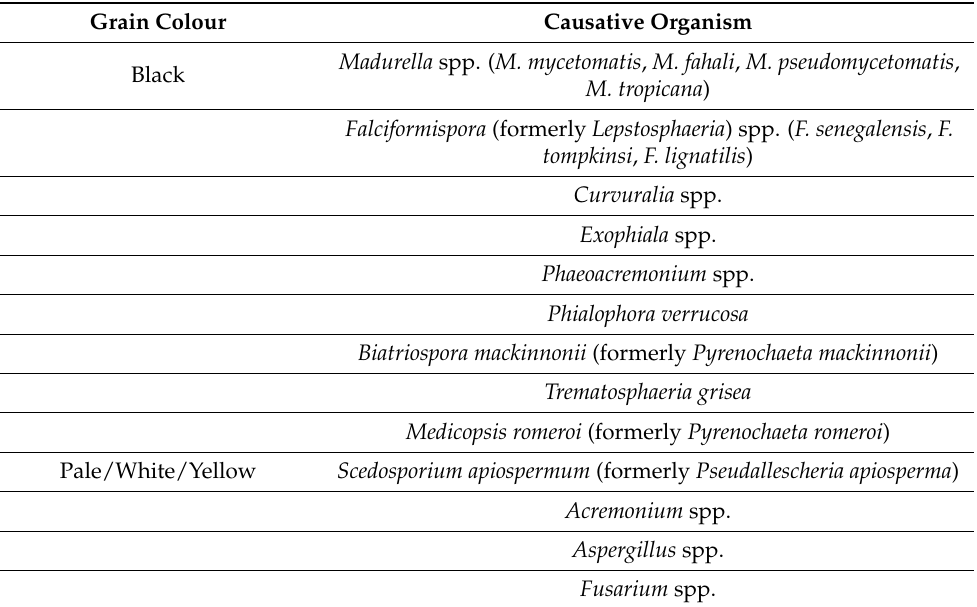
Table 1. Causative agents of